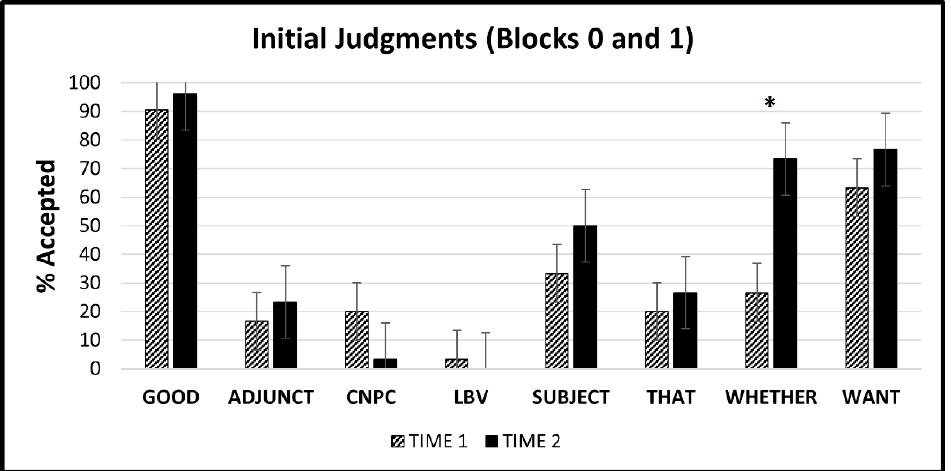
Figure 5. Experiment II: Acceptance of initial sentences (Blocks 0 and 1) at Times 1 and 2; Error bars show standard error; “ * ” indicates significance ( p < .05) by Wilcoxon Signed-Rank Test.